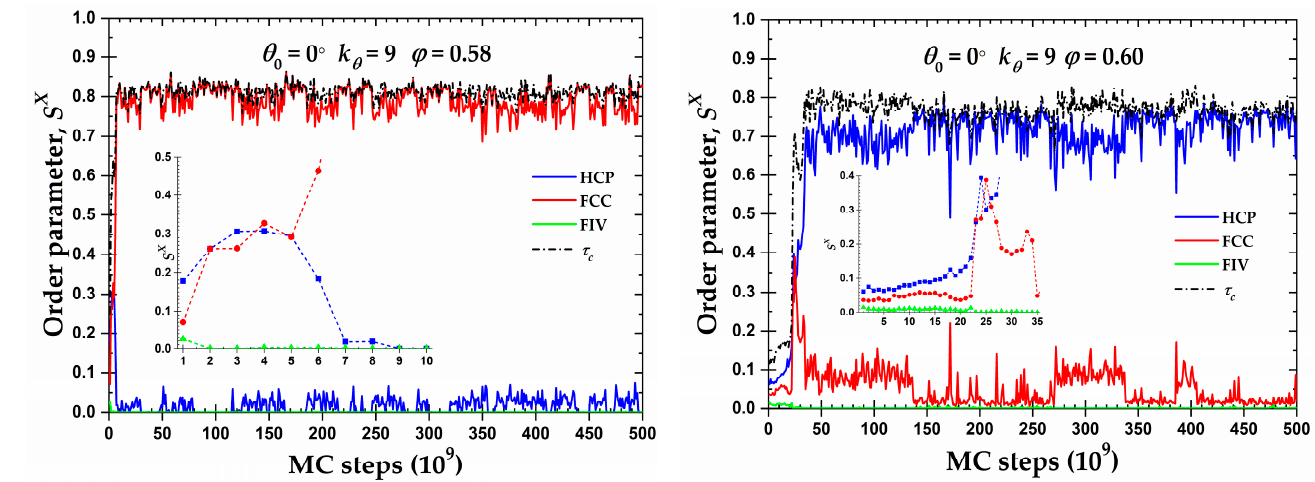
Figure 8. CCE norm order parameter, S X , as a function of MC steps for the 100-chains N av = 12 semi-flexible system chains with bending constant k θ = 9 and equilibrium bending angle θ 0 = 0 ◦ at ϕ = 0.58 (( left panel )) and 0.60 (( right panel )). Inset corresponds to the early part of the MC trajectory (( left ): 10 × 10 9 and ( right ): 35 × 10 9 MC steps). Dashed black line corresponds to the degree of crystallinity, τ c .